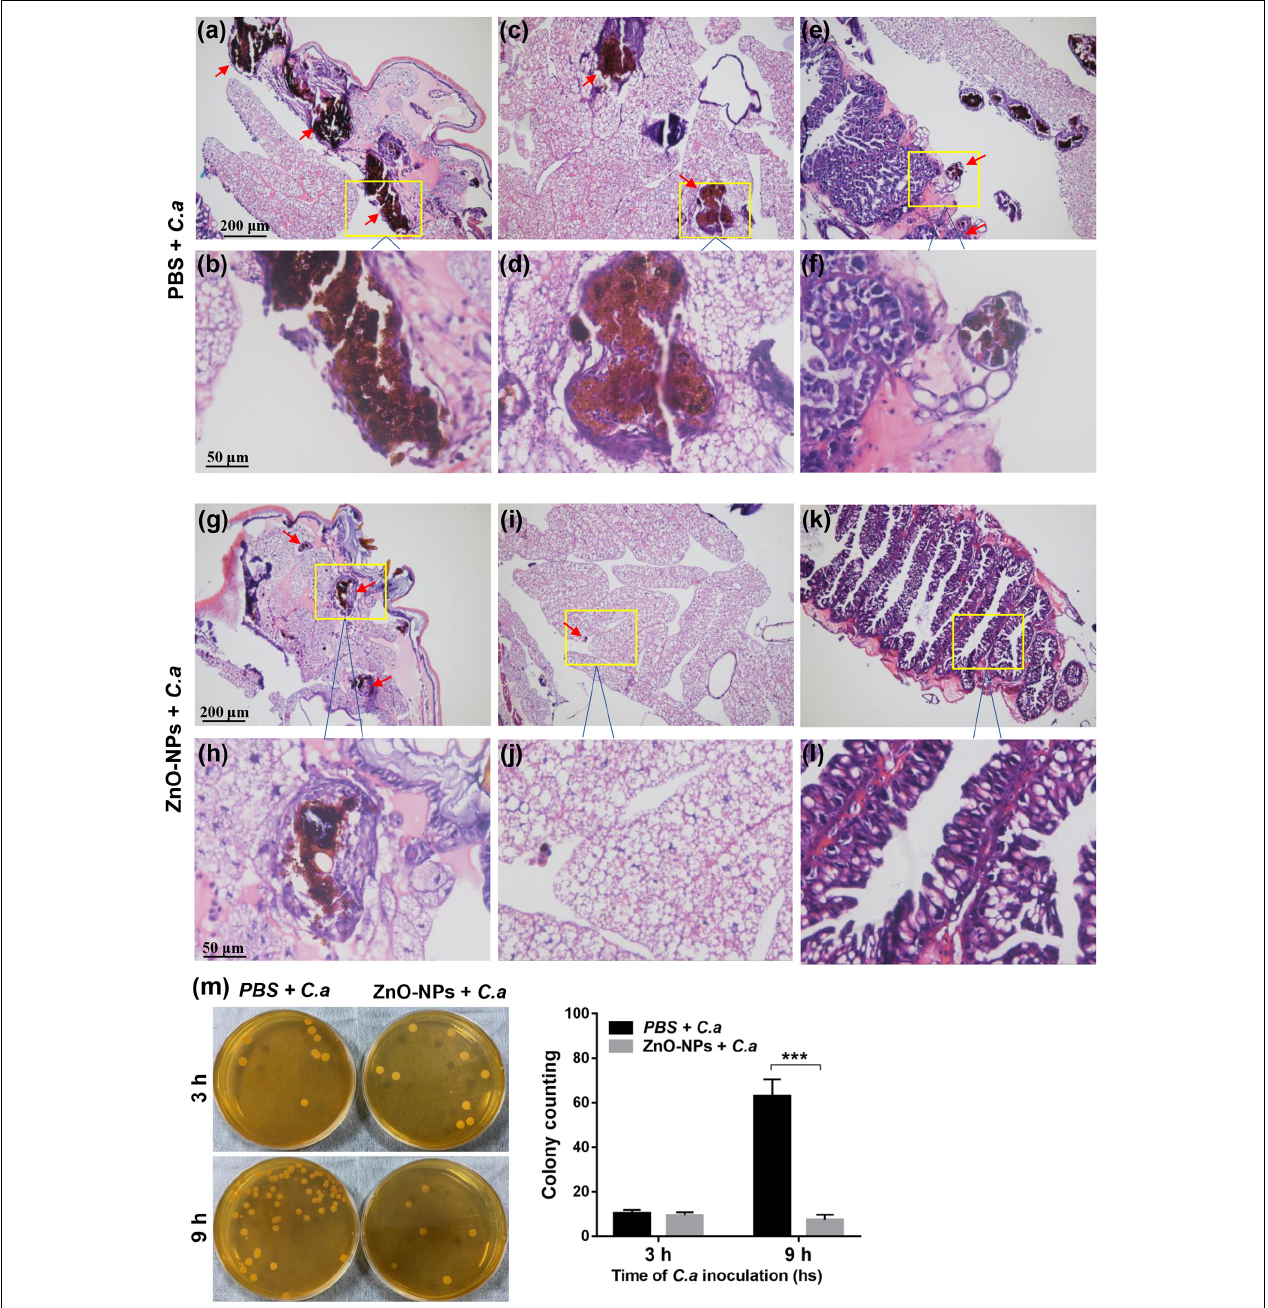
FIGURE 3 | Histopathological analysis and determination of fungal burden in G. mellonella . (a–l) Representative photomicrographs of the fungal morphology, distribution, and burden in G. mellonella on day 2 after ZnO-NP pretreatment and C. albicans inoculation. G. mellonella pretreated with PBS and inoculated with C. albicans was used as the control. Stained sections are shown at × 100 magnification (a,c,e,g,i,k) and × 400 magnification (b,d,f,h,j,l) , respectively. C. albicans were in yeast morphological form and incorporated in melanized nodules among tissues. The strain isolates were visualized in subcuticular areas (a,b,g,h) , fat bodies (c,d,i,j) , and intestinal walls (e,f) . Smaller nodules were observed in ZnO-NP-pretreated G. mellonella (g–j) than in PBS-pretreated control group (a–f) . (k,l) No fungus was detected in the intestines of ZnO-NP-pretreated G. mellonella . (m) The fungal burden in the hemolymph of PBS or ZnO-NP-pretreated G. mellonella after challenge with C. albicans (1 × 10 5 CFU/larva). At 3 and 9 h postinfection, hemolymph was obtained from 15 replicates per group and was diluted 10 times with PBS. Then 100 µ l of diluted hemolymph was plated onto yeast peptone dextrose (YPD) solid medium and incubated at 37 ◦ C for 24 h. Colony counts were measured and shown as mean ± SD. Differences were determined by using the t -test. *** p < 0.001.